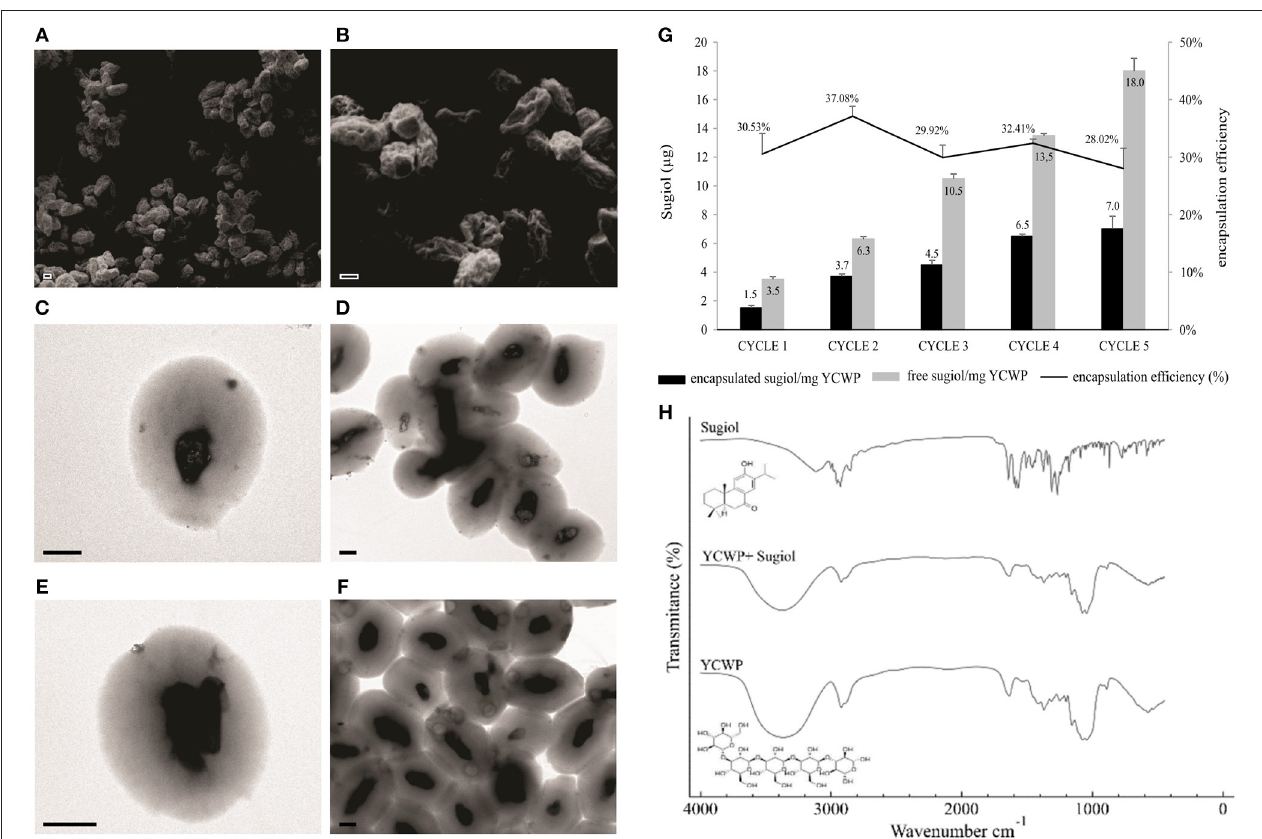
FIGURE 7 | Characterization of YCWPs containing sugiol. (A,B) YCWPs visualized on SEM and TEM, being (C,D) empty YCWPs and (E,F) YCWPs + sugiol (scale bar = 1 µ m). (G) Encapsulation efficiency after each cycle of encapsulation. The results were expressed as the mean ± SD of the mass per mg of YCWPs and percentage of sugiol inner and out of the particles from three independent experiments. Letter (H) shows the FT-IR spectrum obtained from empty YCWPs, YCWPs containing sugiol, and sugiol.